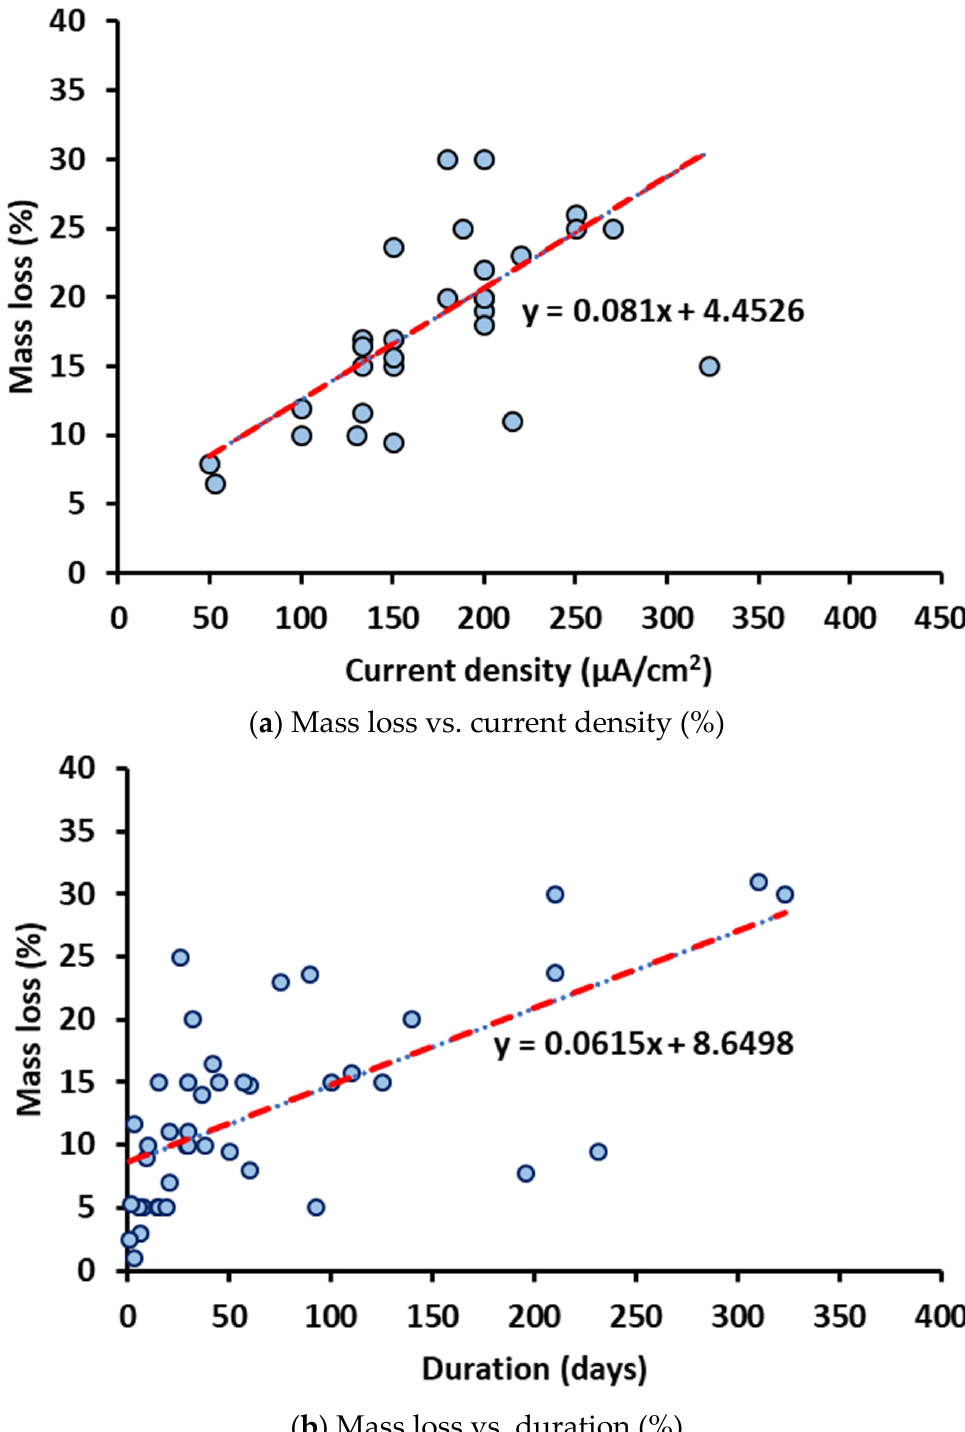
Figure 11. In fl uences of di ff erent parameters on mass loss in steel reinforcement. Figure 11. Influences of different parameters on mass loss in steel